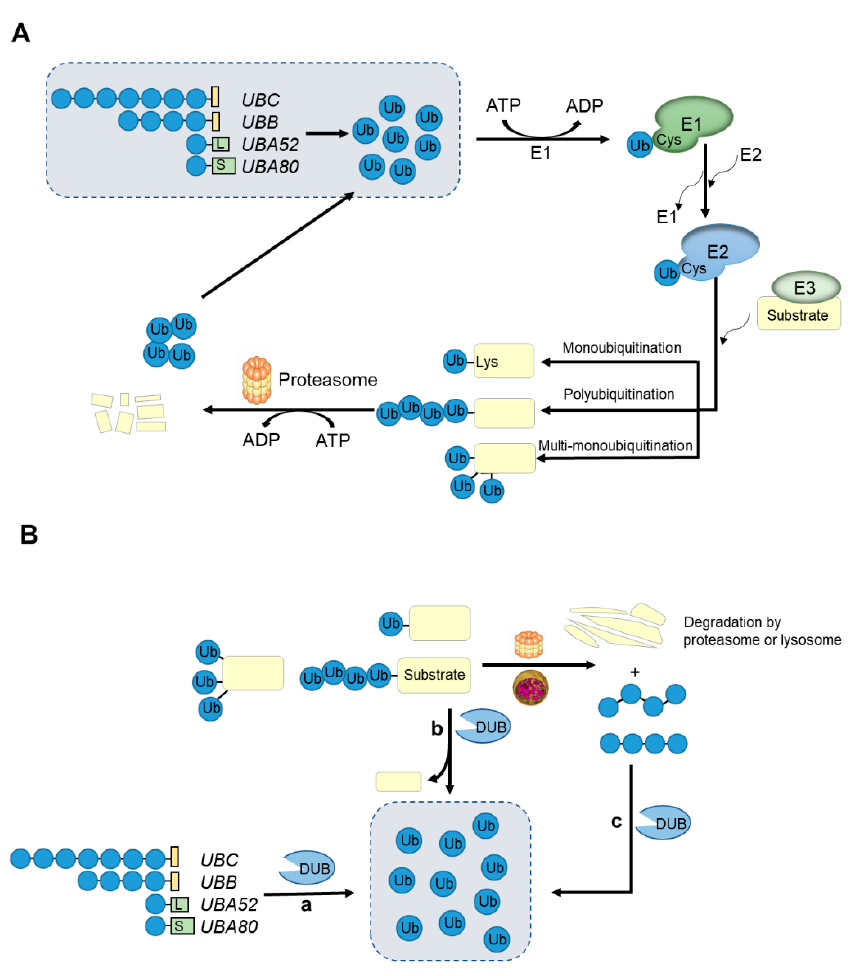
Figure 1. An overview of the ubiquitin-proteasome system and the roles of deubiquitinases (DUBs). ( A ) Ubiquitin is conjugated to substrate proteins by the ATP-dependent successive actions of E1, E2, E3 enzymes that result in target proteins degrading in the 26S proteasome. Proteins can be modified by a single ubiquitin at one or multiple sites or by ubiquitin chains with different lengths and linked sites. ( B ) Ubiquitination is a reversible modification, which is performed by the deubiquitinases. Deubiquitinases (DUBs) can recycle ubiquitin in three ways to maintain the ubiquitin level in cells: ( a ) generate monomeric ubiquitin from precursor proteins encoded by four genes; ( b ) specifically remove ubiquitin or ubiquitin chains from substrate proteins; ( c ) recycle ubiquitin from proteins degraded by proteasomes or lysosomes.